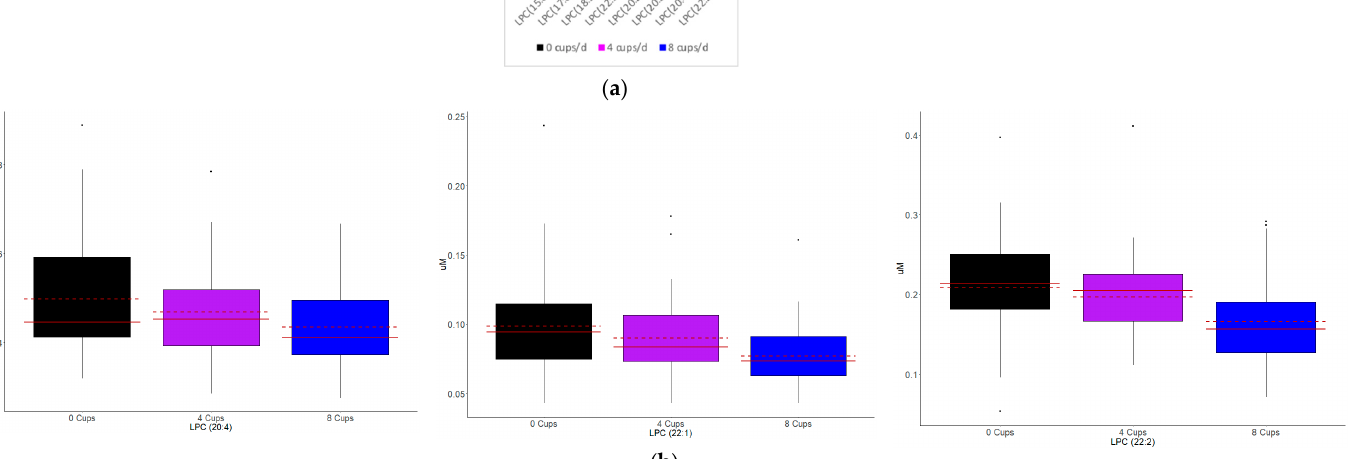
Figure 2. LPC concentration response to coffee intake. Shown are all nominally ( a ) to significant ( a , b ) LPCs that changed in response to coffee.